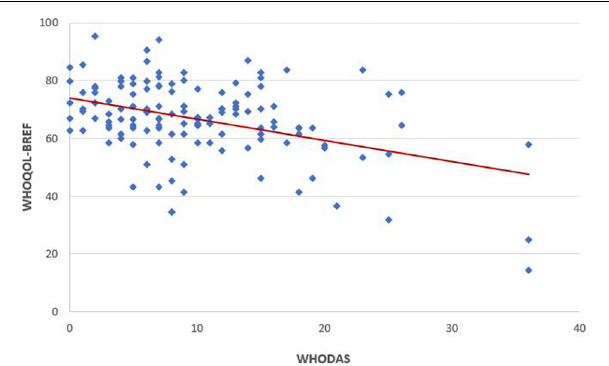
FIGURE 2 | Correlation of quality of life (WHOQOL-BREF) to levels of functioning (WHODAS). Pearson correlation analysis shows a weak negative correlation of WHODAS versus WHOQOL-BREF (Pearson r = 0.41; n = 135). Line represents linear regression of data ( y = –0.74x + 73.94; r 2 =